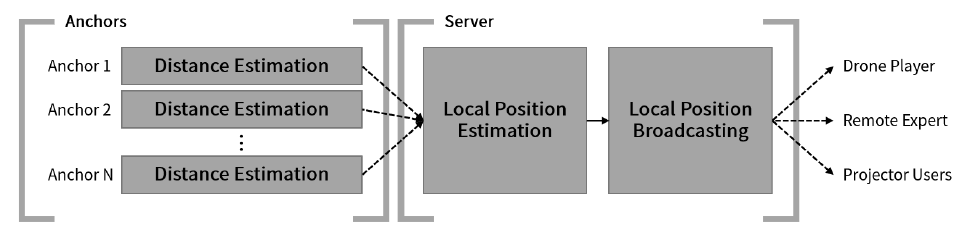
Figure 24. Virtual flight environment configuration using UWB